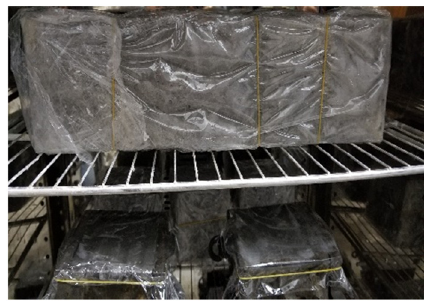
Figure 6: Production fl ow